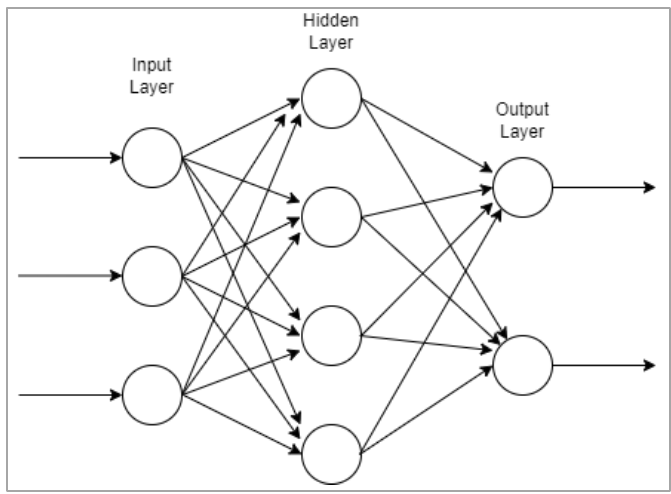
Figure 1. A Multi-layer feed forward neural network.